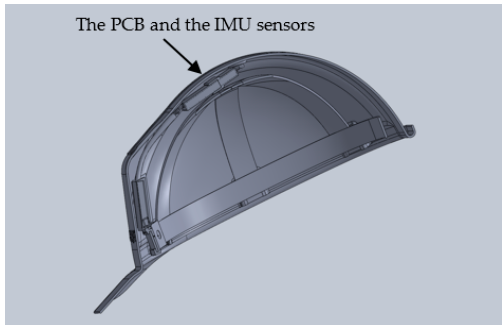
Figure 2. The instrumented safety helmet prototype.